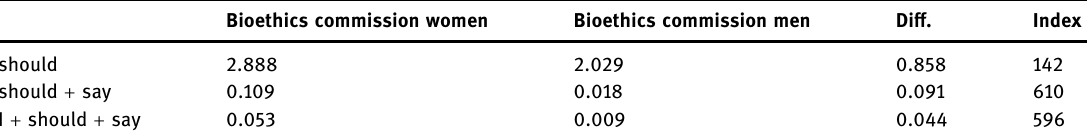
Table 20: Collocation of “ should ” with say, as per cent of total tokens ( normalised, n = 1,000 )